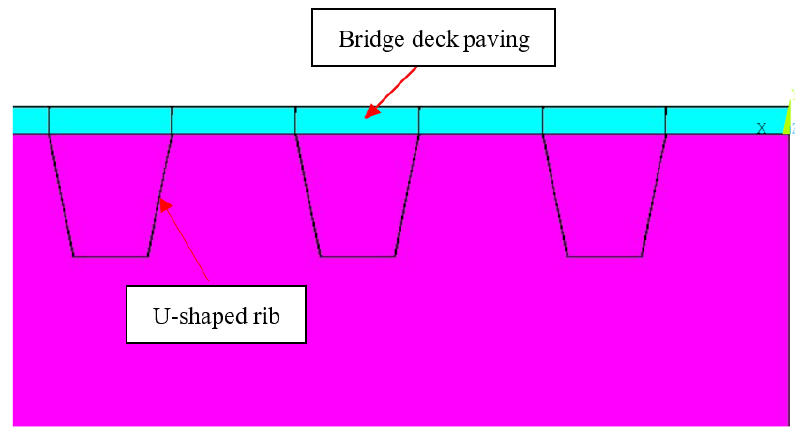
Figure 5. Numerical simulation of composite structure of steel bridge deck pavement.